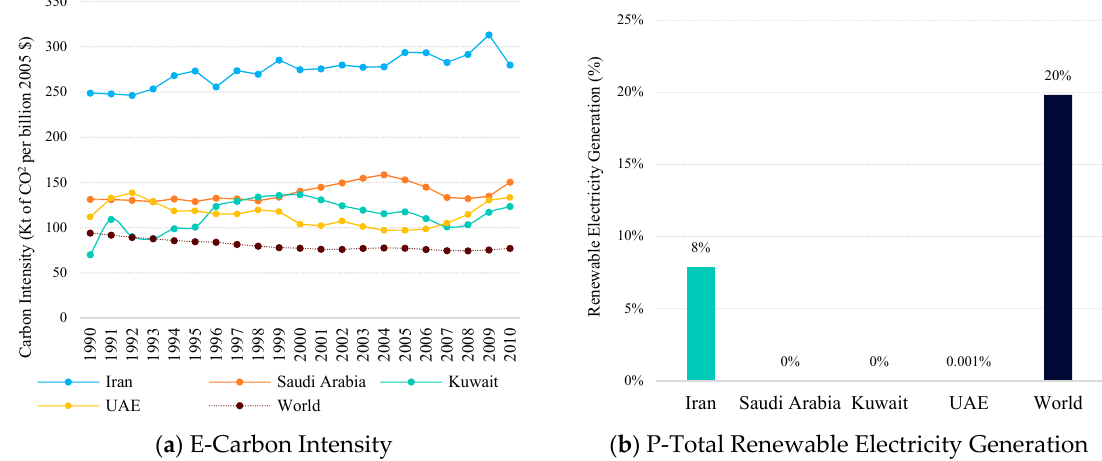
Figure 10. ( a ) Environmental indicator for STEEP (Carbon Intensity); ( b ) Political indicator (Renewable Electricity Generation).